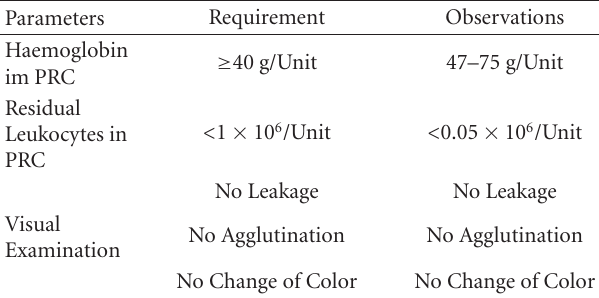
Table 4: Requirements for PRC.